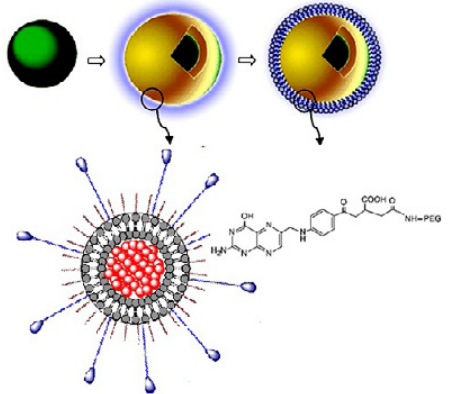
Fig. 3. Schematic of liposome-encapsulated FSG